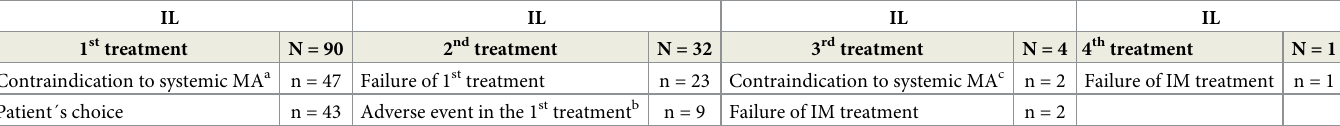
Table 2. Indications for treatment with intralesional meglumine